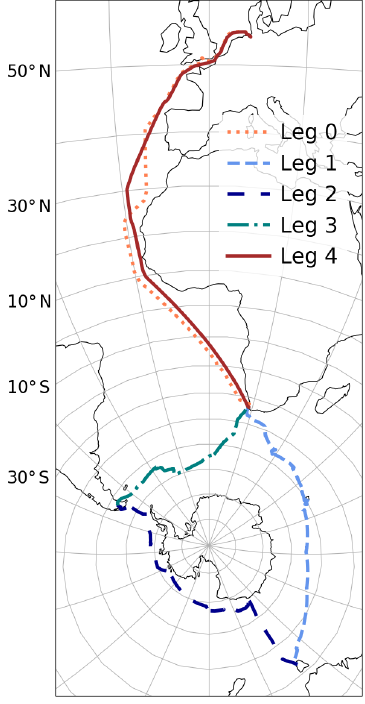
Figure 1. Overview of the ACE cruise from November 2016 to April 2017. The five legs (coloured lines) took place